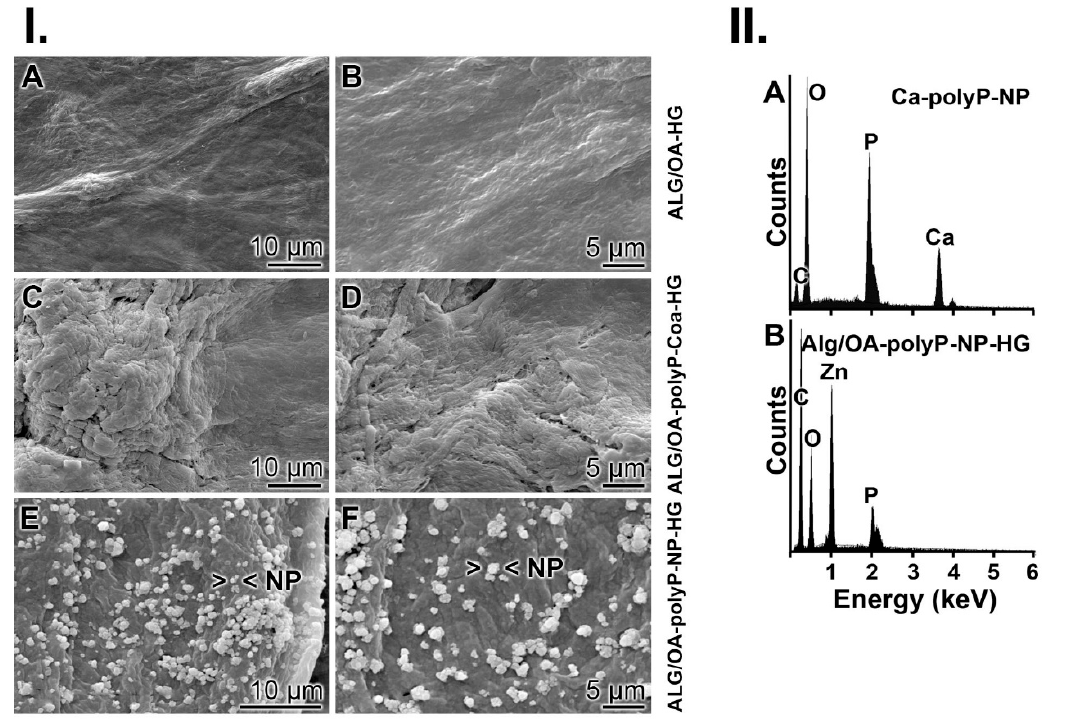
Figure 4. Morphology and characterization of the hydrogels. ( I. ) Surface texture of the different hydrogels; ESEM. ( A , B ) The polyP lacking hydrogel, “ALG/OA-HG”. This hydrogel was supplemented with Na-polyP and then treated with ZnCl 2 . ( C , D ) At pH 7 polyP forms a coacervate, “ALG/OA-polyP-Coa-HG”, while ( E , F ) the surface of the material, composed of alginate/OA- 50/gelatin and polyP, and obtained at pH 10, is covered with nanoparticles (NP), “ALG/OA-polyP- NP-HG”. ( II. ) EDX spectra, taken from ( A ) Ca-polyP-NP and ( B ) “ALG/OA-polyP-NP-HG”.